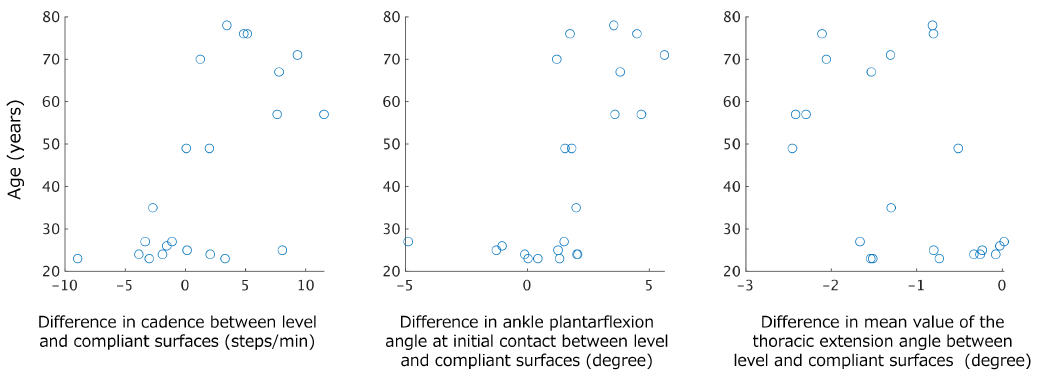
Figure 5. Scatter plot between age and floor surface-related changes in gait